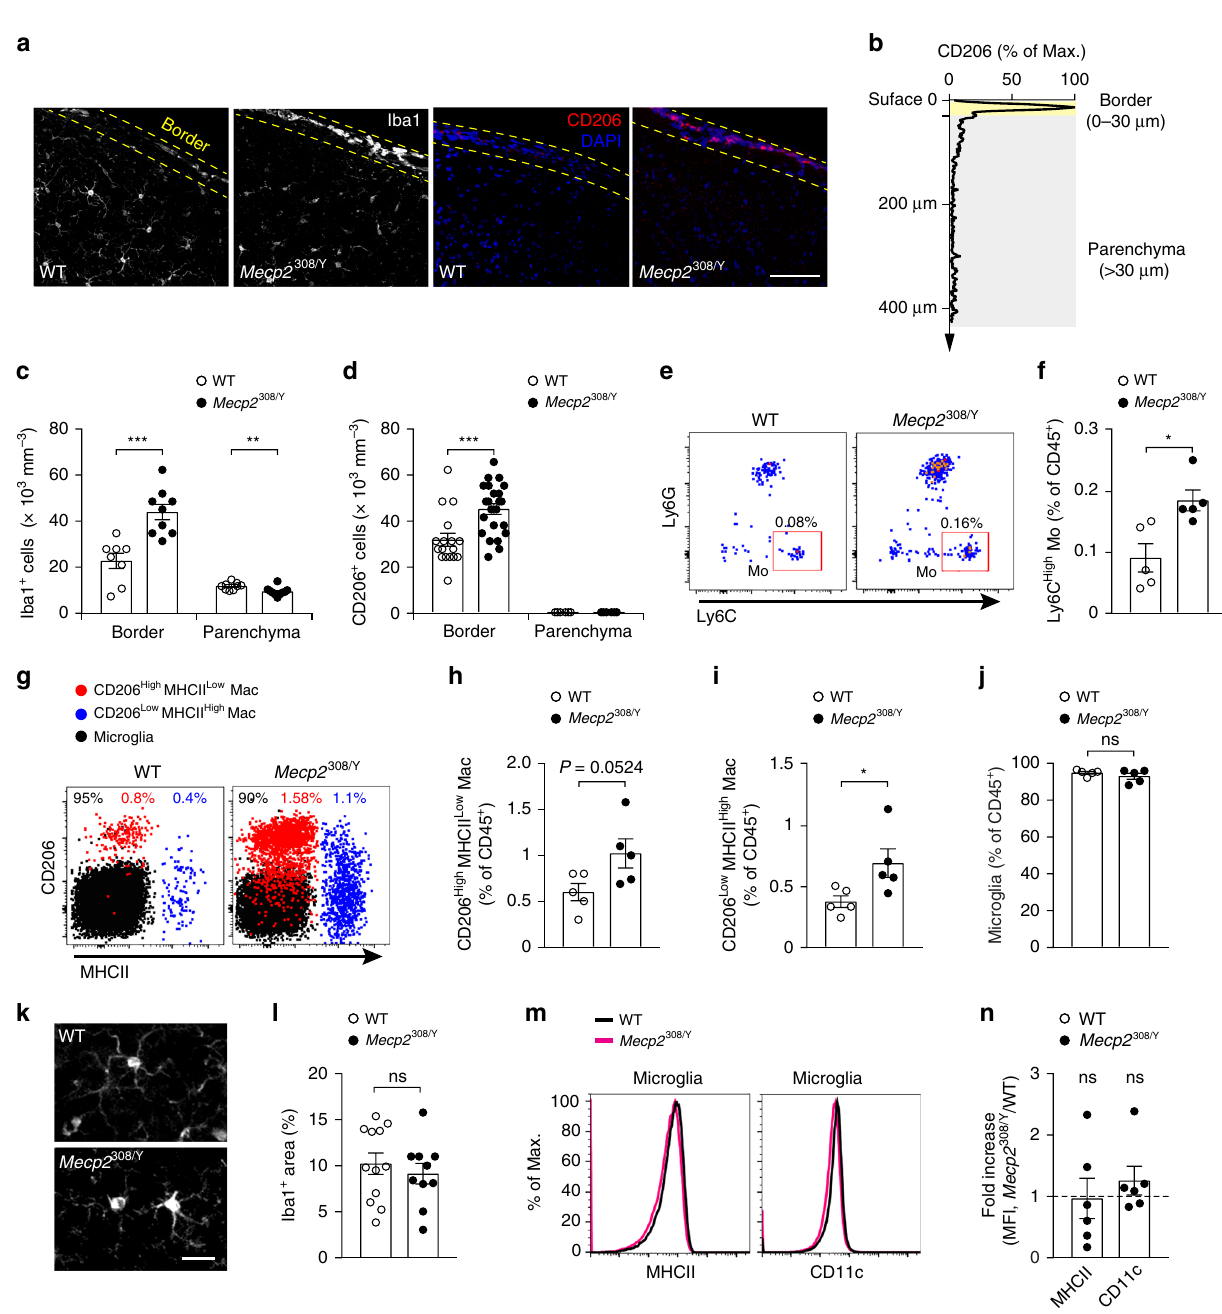
Fig. 1 Mecp2 308/Y mice have more monocytes and macrophages in the cortical border. a Representative coronal sections of the mouse cortex stained for Iba1 and CD206 in WT and Mecp2 308/Y mice (4 – 6 months old). Dotted yellow lines indicates the border region (within 30 µ m from pial surface) of the cerebral cortex. Scale bar, 80 µ m. b Representative distribution of CD206 fl uorescence intensity across the depth of the cortex. CD206 expression was mainly observed in the border region of the cortex. c Quanti fi cation of Iba1 + cell density in the cortical border ( n = 8, 9; P = 0.0004) and parenchyma ( n = 9, 10; P = 0.0096). Empty circle, WT; Filled circle, Mecp2 308/Y . d Quanti fi cation of CD206 + cell density in the cortical border ( n = 17, 23; P = 0.0007) and parenchyma ( n = 6, 6). e Representative fl ow cytometry analysis showing the percentages of Ly6C High monocytes (Mo) in the cortex of WT and Mecp2 308/Y mice. f Quanti fi cation of data shown in ( e ) ( n = 5, 5; P = 0.0113). Monocytes were gated from CD45 High CD11b + MHCII − Ly6G − cells. g Representative fl ow cytometry analysis showing surface expression of CD206 and MHCII in microglia and macrophages (Mac) of WT and Mecp2 308/Y mice. h – j Percentages of CD206 High MHCII Low macrophages ( P = 0.0524), CD206 Low MHCII High macrophages ( P = 0.0393), and microglia ( P = 0.3278) in the cortex of WT and Mecp2 308/Y mice ( n = 5 mice per group). Relative numbers are expressed as percentages of CD45 + cells. k Representative images of microglia in the cortex of WT and Mecp2 308/Y mice. Scale bar, 25 µ m. l Quanti fi cation of area covered by Iba1 + microglia ( n = 12, 10; P = 0.5123). m Histograms showing distribution of surface MHCII and CD11c expression in cortical microglia in WT or Mecp2 308/Y mice. n Quanti fi cation of data shown in m ( n = 6 per group, P = 0.9178 and 0.3032). Data are presented as mean ± SEM. * P < 0.05, ** P < 0.01, *** P < 0.001, ns not signi fi cant, unpaired